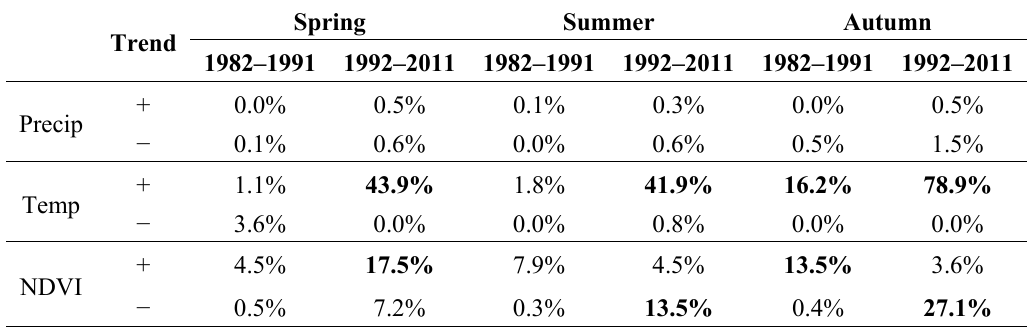
Table 1. Area percentage of significantly ( p -value < 0.05) positive (+) and negative ( − ) trends for precipitation (Precip), temperature (Temp), and NDVI for all Central Asian vegetated areas in 1982–1991 and 1992–2011. Spring Summer Autumn Trend